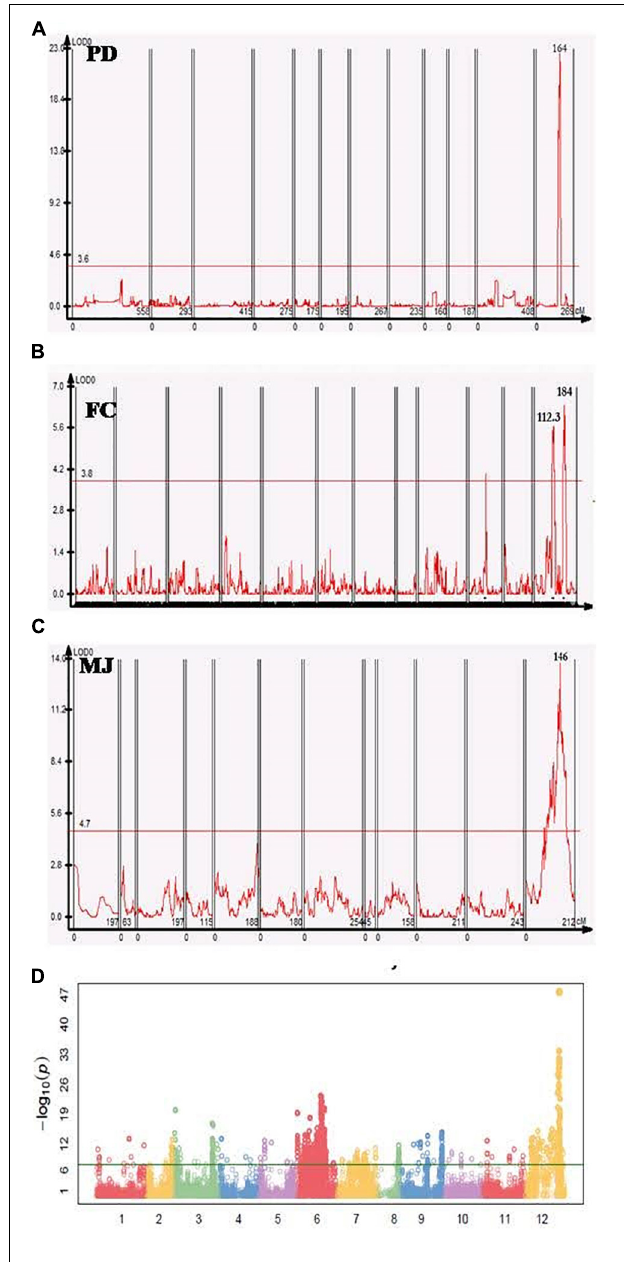
FIGURE 2 | Genome-wide association study (GWAS) and QTL analyses of fruit orientation in different populations. (A–C) Fruit orientation QTLs in the PD, FC, and MJ populations, all of which have similar significant QTL regions on chromosome 12. One peak was present in PD, two peaks were detected in FC, and one peak was detected in MJ. (D) Manhattan plot of the core collection, showing a significant peak on chromosome 12 (–LogP of 47) associated with fruit